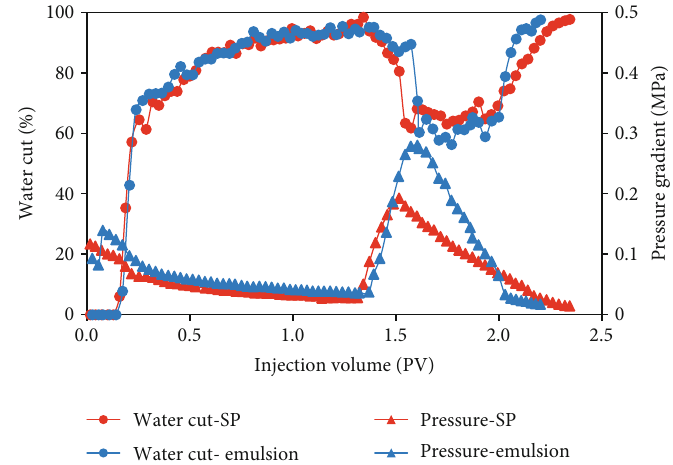
Figure 7: Water cut vs. injection amount and pressure gradient vs. injection amount in two experimental